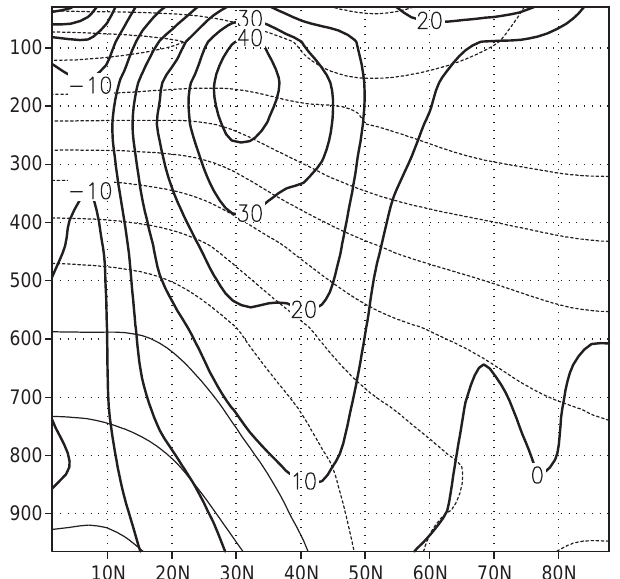
Fig. 1. Zonal mean base state taken from the control integration of the UK Meteorological O(cid:129)ce climate model. Thick solid contours show zonal wind (contour interval 10 m s (cid:255) 1 ). Lighter contours show temperature (contour interval 10 (cid:14) C, solid and zero contours solid , negative contours dashed )